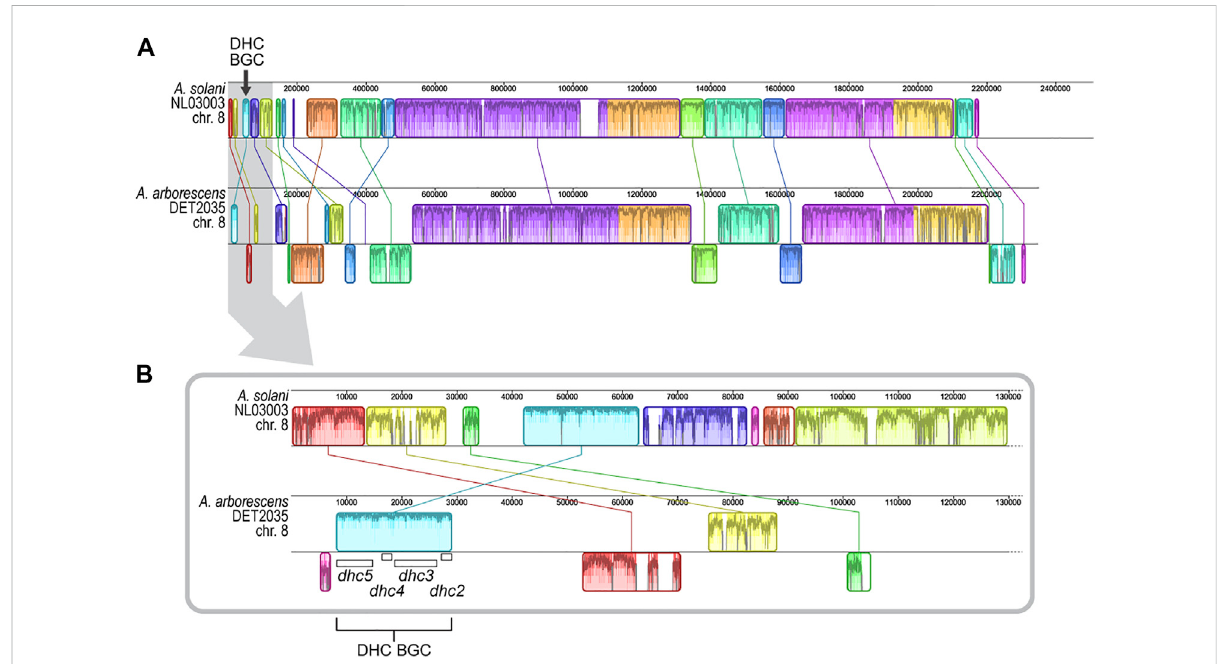
FIGURE 4 Alignment of genome regions from A. arborescens DET2035 and A. solani NL03003. Locally collinear blocks (LCBs) are shown in matching colors and linked by lines. LCBs shown below the horizontal centre line in A. arborescens DET2035 have inverse orientation in comparison to A. solani NL03003. Regions outside LCBs lack detectable homology between the genomes. Within each LCB, the height of the similarity plot corresponds to the average level of sequence conservation in that region, and sections in white are unique to that speci fi c genome. (A) Alignment of full-length chromosome 8. (B) Alignment of the fi rst 130 Kb of chromosome 8 (area highlighted in grey in panel A). The location of the four dhc genes are